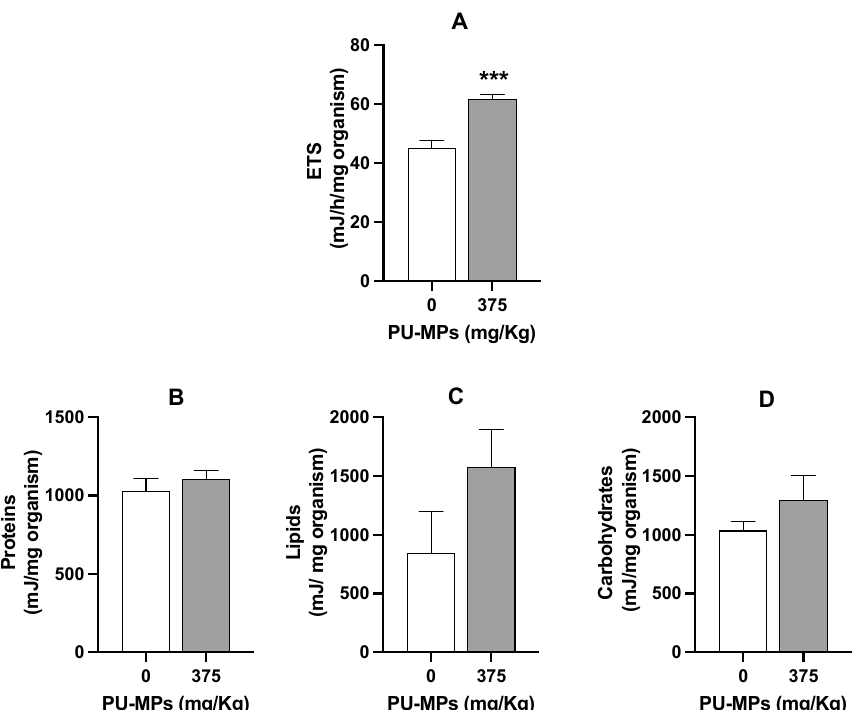
Figure 5. Effect of polyurethane microplastics (PU-MPs) on ( A ) aerobic energy production (electron transport system, ETS, mJ/h/mg organism), ( B ) proteins, ( C ) lipids, and ( D ) carbohydrates content (mJ/mg organism) of Chironomus riparius larvae after 10 days of exposure (n = 5). All values are presented as mean ± standard error of the mean. *** denotes a significant difference from the control ( p < 0.001).